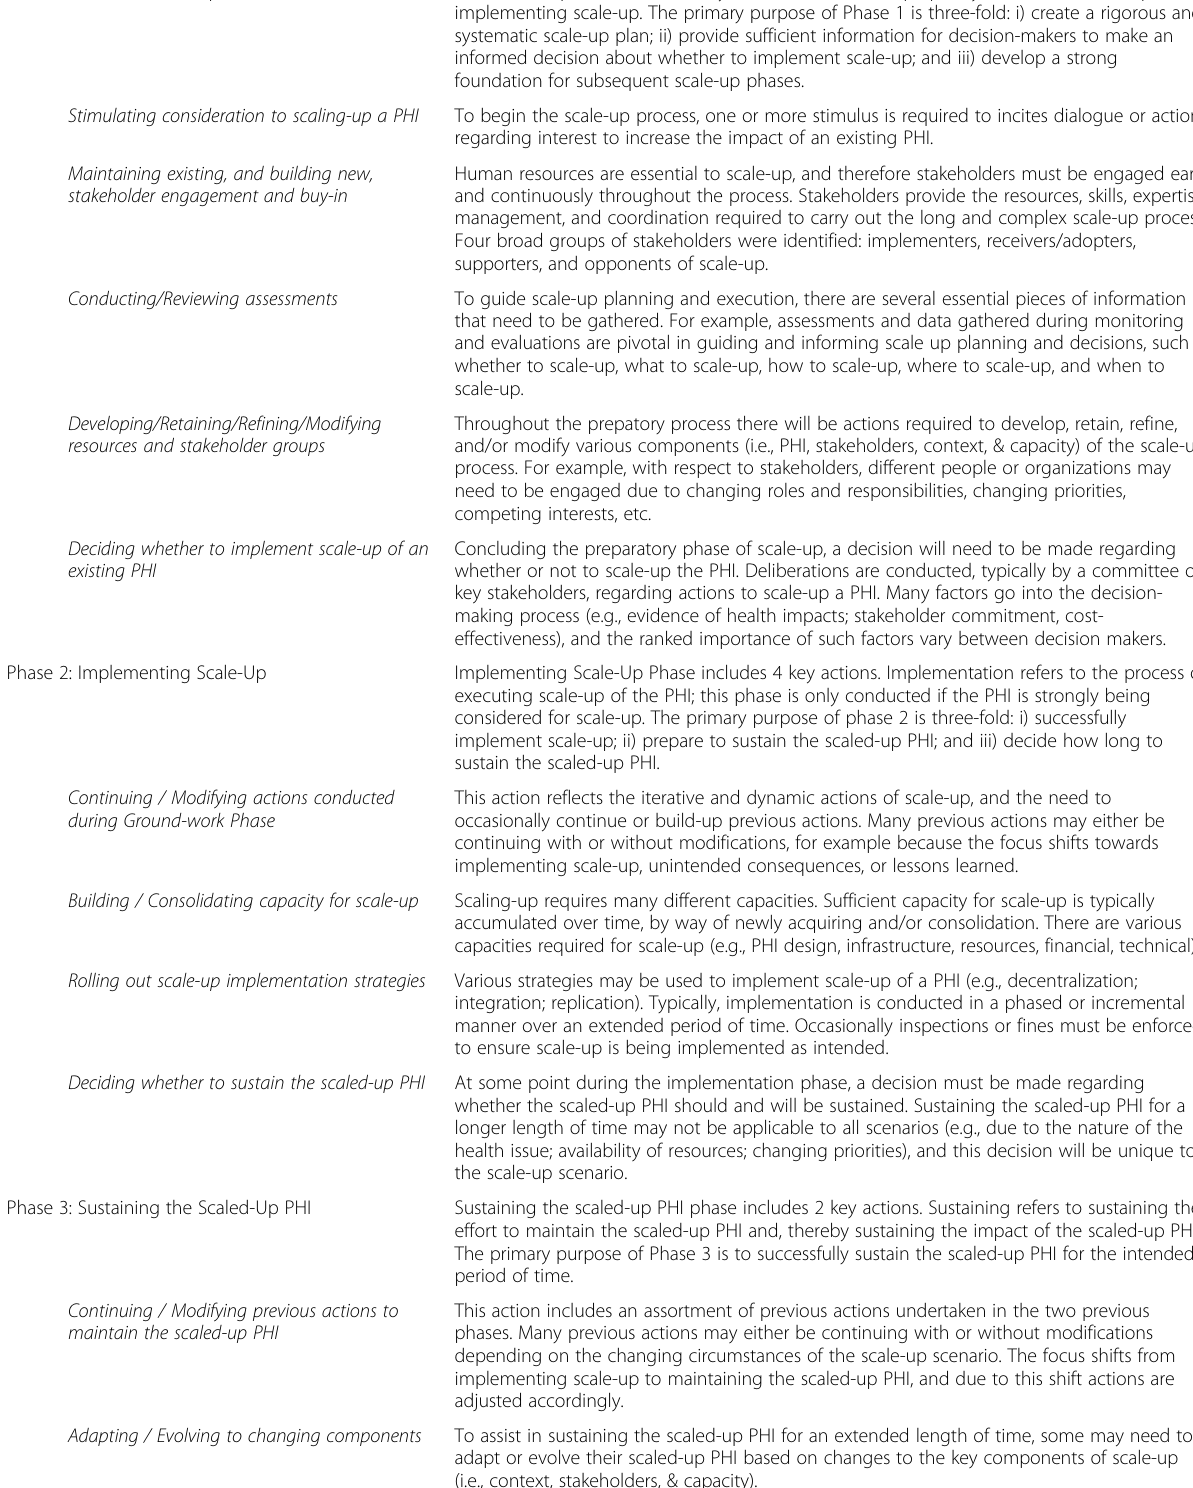
Table 3 Key phases and actions in the pathway to successfully scaling-up a